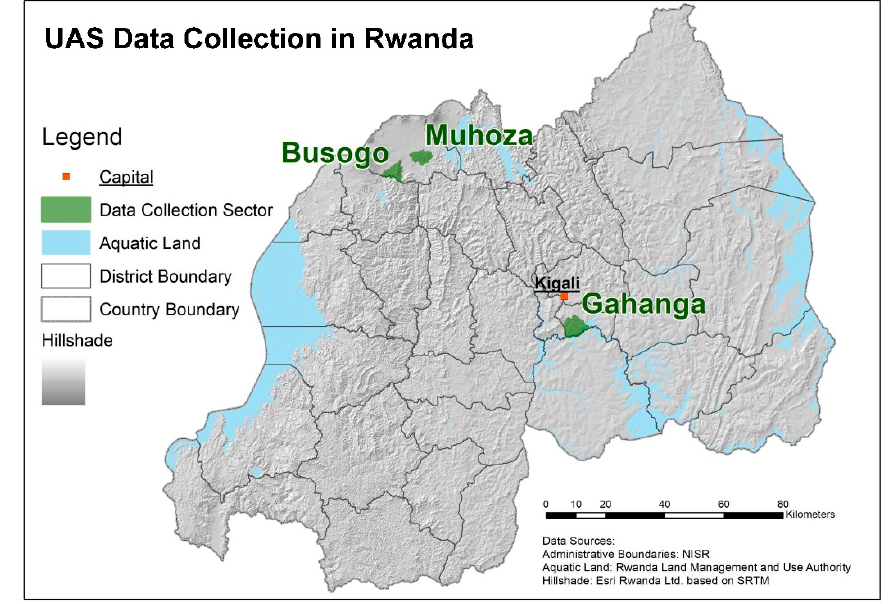
Figure 3. Overview of UAS data collection sites in Rwanda.